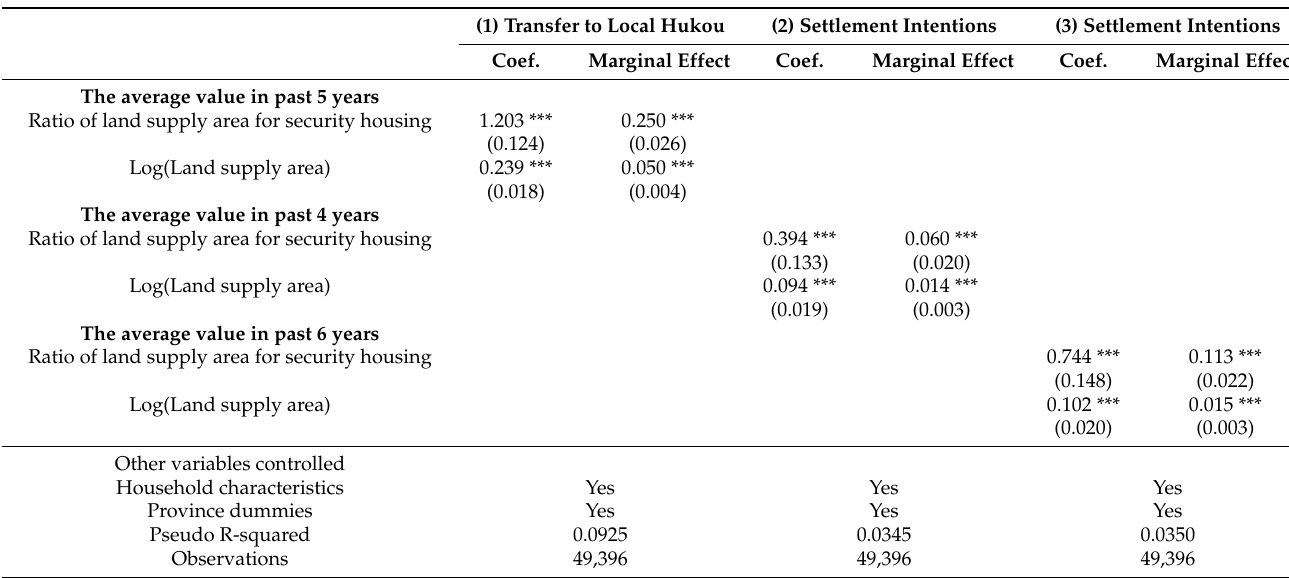
Table 3. Estimated results of housing security and settlement intentions (Alternative definitions of